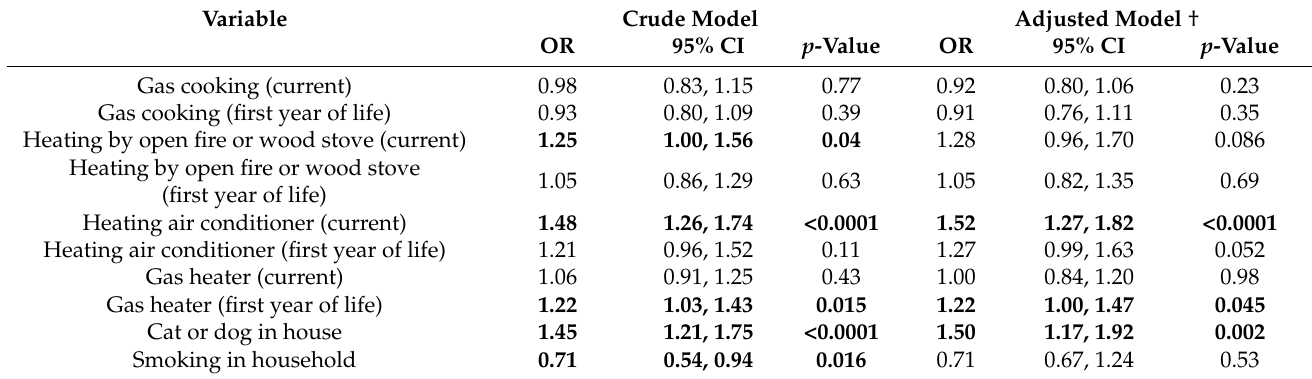
Table 2. Associations between indoor environmental exposures and otitis media.